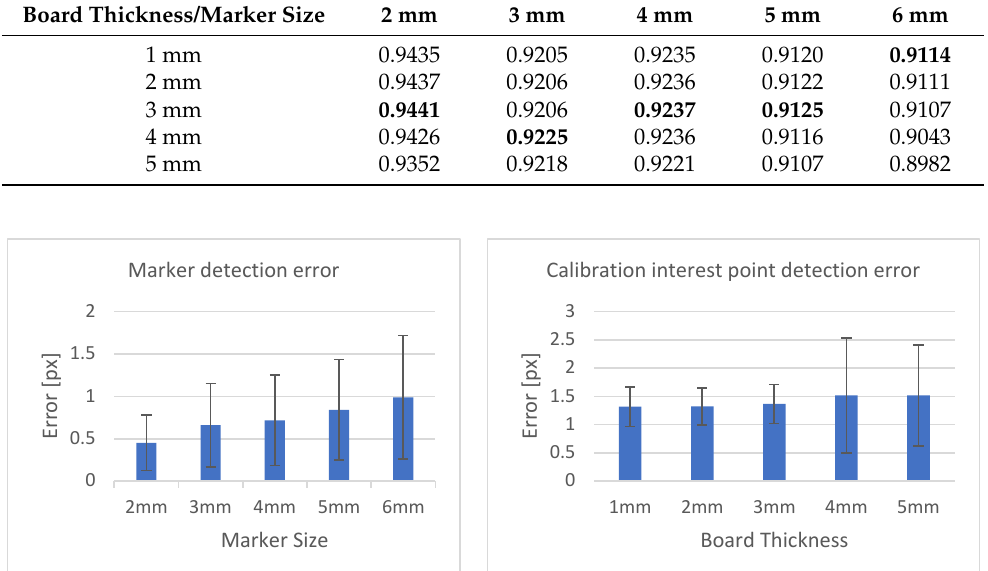
Figure 10. The number of inlier projection images as the size of the planar marker and calibration board thickness changes.